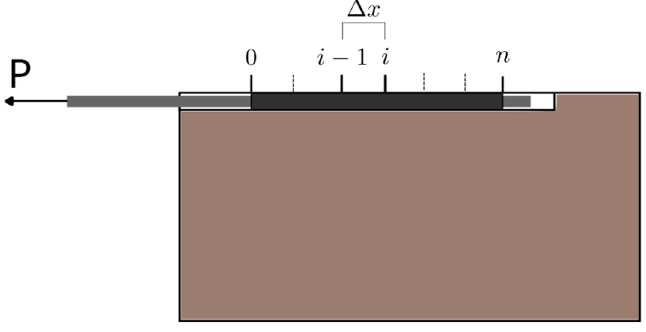
Figure 2. Scheme of the discretization along the FRP.